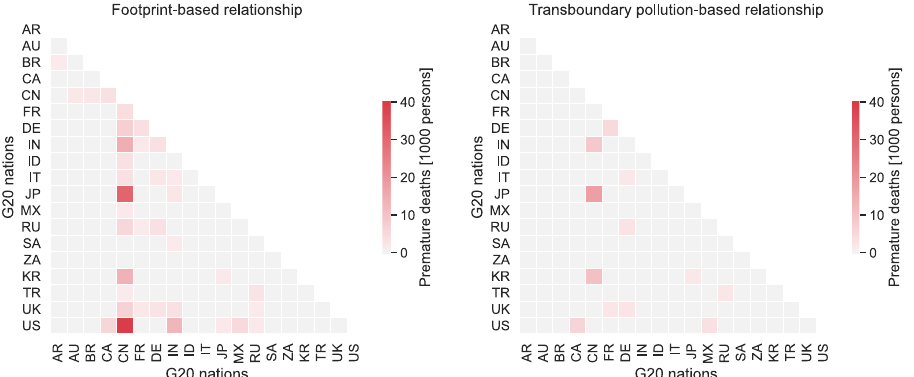
Fig. 1 Comparison of footprint-based and transboundary pollution-based relationships among G20 nations for the number of PM 2.5 -related premature deaths. Country codes as follows: Argentina (AR), Australia (AU), Brazil (BR), Canada (CA), China (CN), France (FR), Germany (DE), India (IN), Indonesia (ID), Italy (IT), Japan (JP), Mexico (MX), Russia (RU), Saudi Arabia (SA), South Africa (ZA), South Korea (KR), Turkey (TR), United Kingdom (UK), and United States